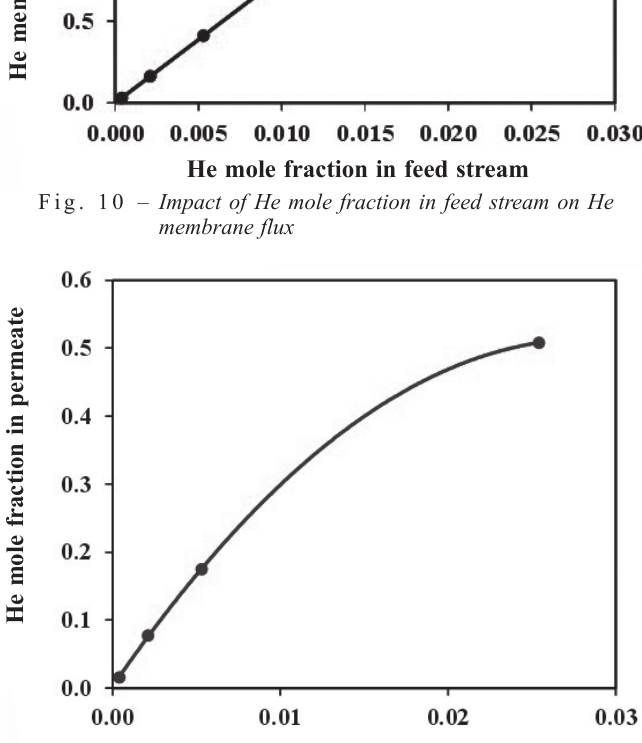
Fig. 11 – Impact of He mole fraction in feed stream on He mole fraction in permeate